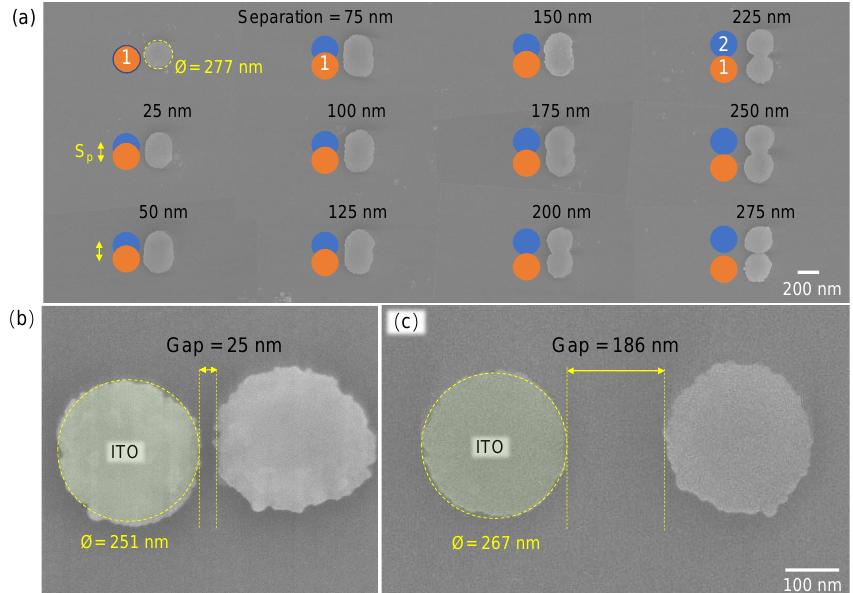
Figure 1. SEM images of ITO structures by nano-printing. ( a ) Two pulse-burst exposure of ITO film after wet etching in 1% vol. HF solution for 5 s. The ITO was printed using two laser-pulse bursts (515 nm/280 fs/10 pulses per burst/ pulse energy E p = 0.92 ± 0.02 nJ (on sample)) at separations S p varying from 0 to 300 nm. Focusing was performed using an NA = 0.9 objective lens; polarisation linear (horizontal). Nanogaps can be controlled from 25 nm ( b ) to a size ten-times larger ( c ). Numerical aperture of the objective lens was NA = 0.9 (focal spot diameter (cid:11) = 1.22 λ / NA = 698 nm), thickness of ITO films d ≈ 60 nm. Polarisation of laser pulses ( b , c ) was linear